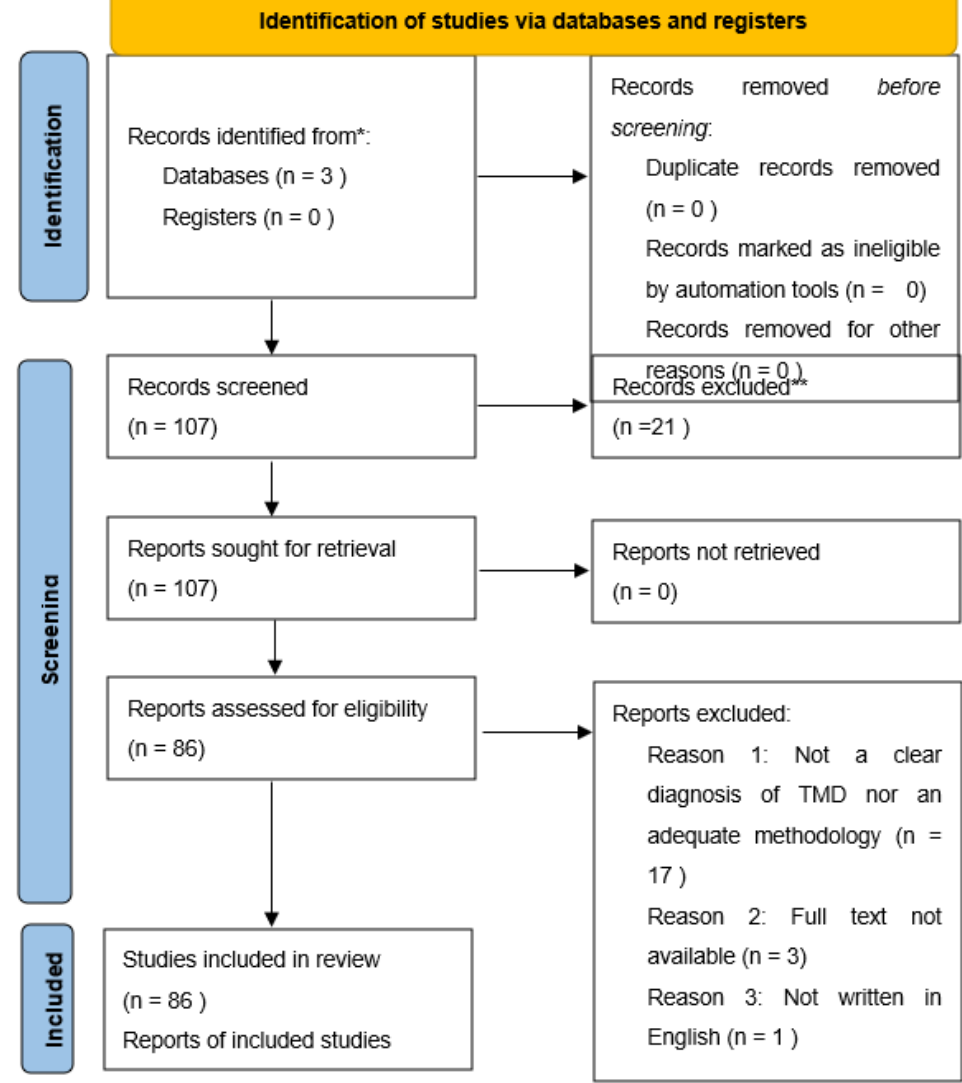
Figure 1. PRISMA 2020 flow diagram. * MEDLINE, Web of Science, and Cochrane, ** EMBASE.